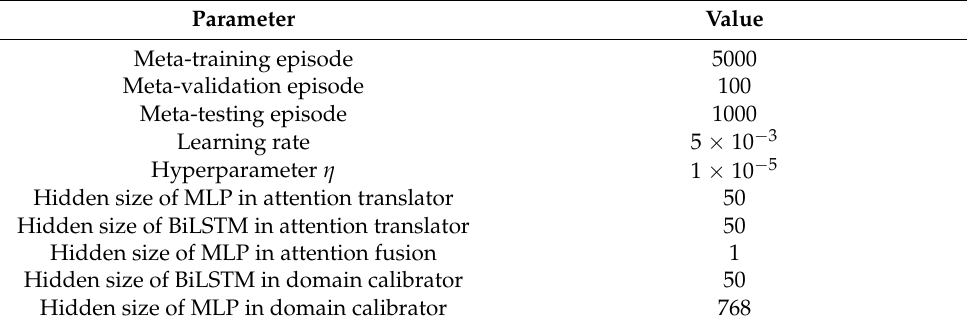
Table 4. Parameter settings for model training and network architecture.